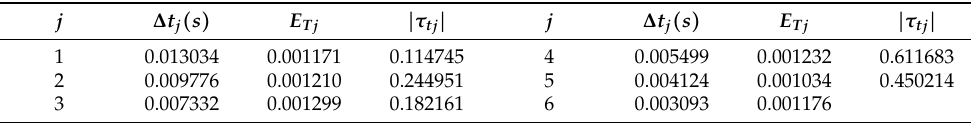
Table 2. Rates of convergence of our numerical scheme in terms of time ( t